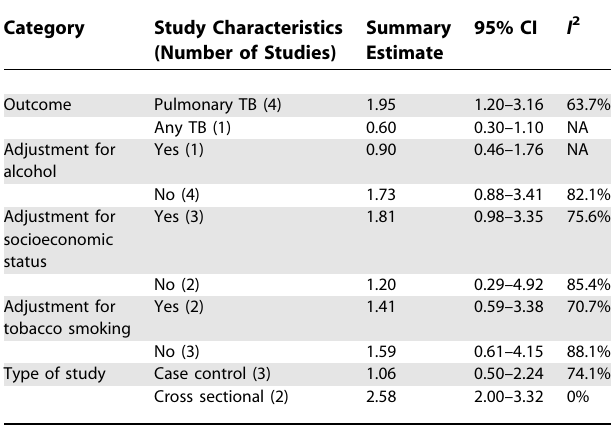
Table 6. Quality Assessment and Subgroup Analysis: Indoor Air Pollution and TB